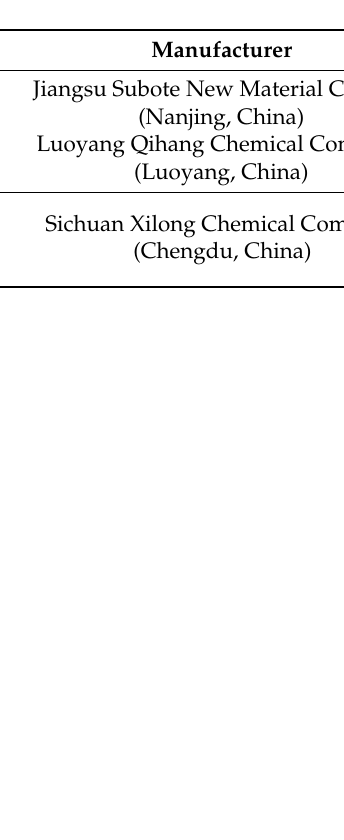
Table 2. Details of the chemicals.